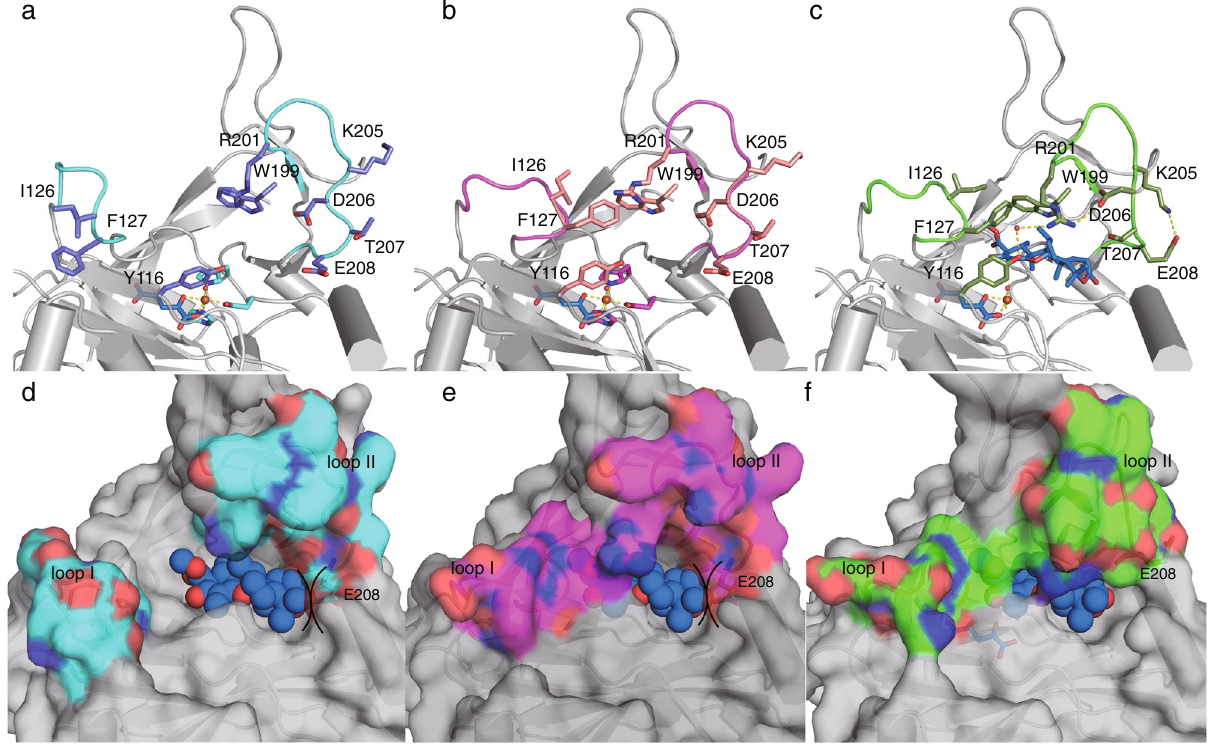
Fig. 4 Active site structure of NvfI. a – c The active site architectures of NvfI. a State I with α -KG, ( b ) state II with NOG and ( c ) state III in complex with 2 and α -KG. Dashed yellow lines represent hydrogen bonds. d – f Surface views of the active site of NvfI, ( d ) State I with α -KG, ( e ) state II with NOG and ( f ) state III in complex with 2 and α -KG. The ligand was superimposed in the α -KG binding structures (state I and II) of NvfI in panel ( d ) and ( e ) to show the steric hindrance between the substrate and